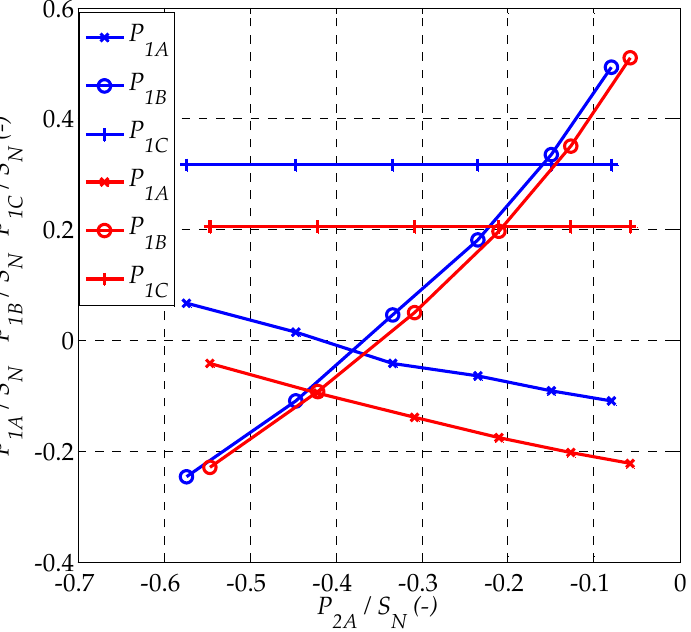
Figure 4. Active powers of the transformer’s primary phases with R or RL load of B and C phases (as in Figure 3), with phase control.